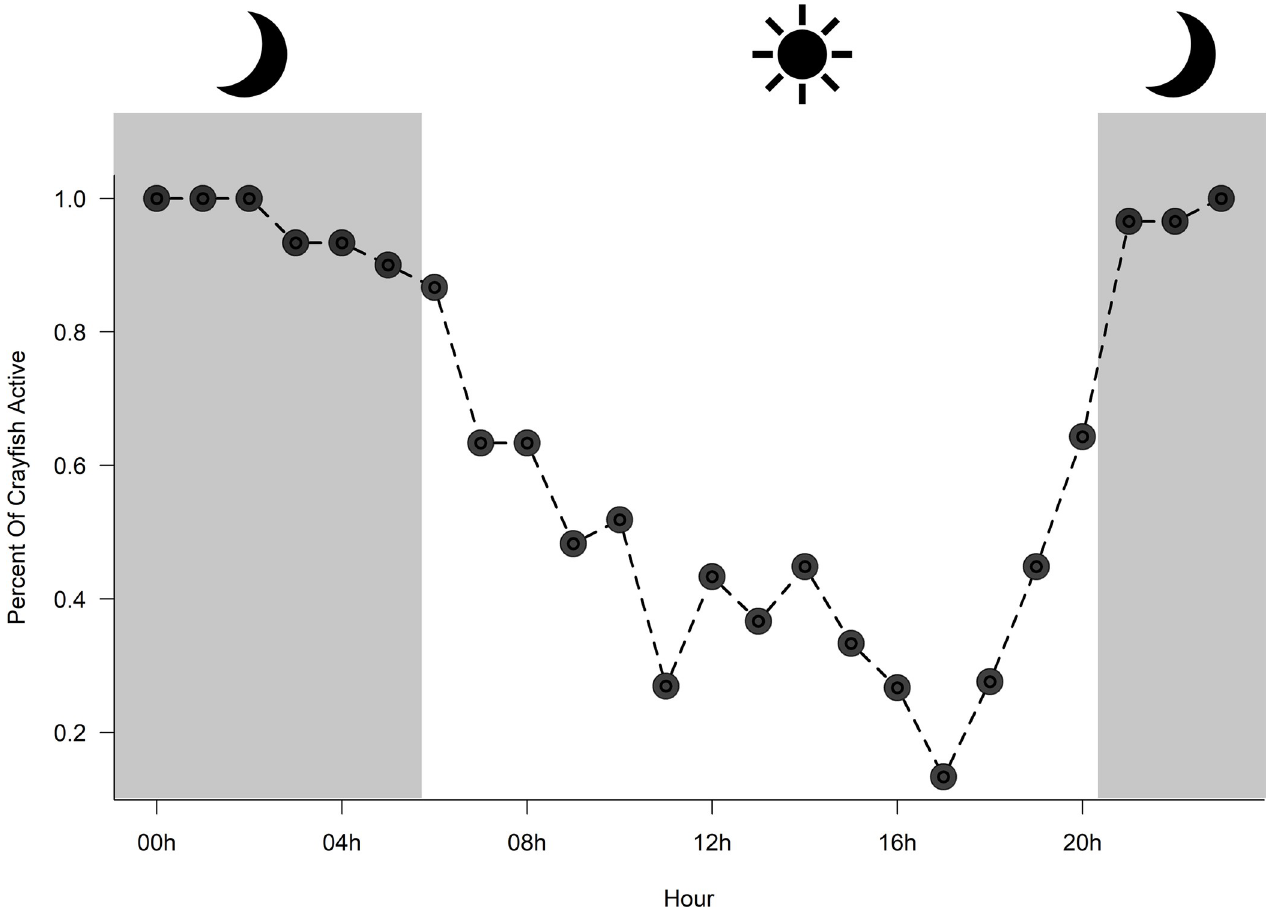
Fig 4. The percent of Lacunicambarus thomai (n = 6) that were active for each hour during our study. Gray areas represent the civil twilight time for our study period that represents the transition between day and night. Crayfish were more likely to be active during the night than during the day. Data is reported from all crayfish throughout the entire period of our